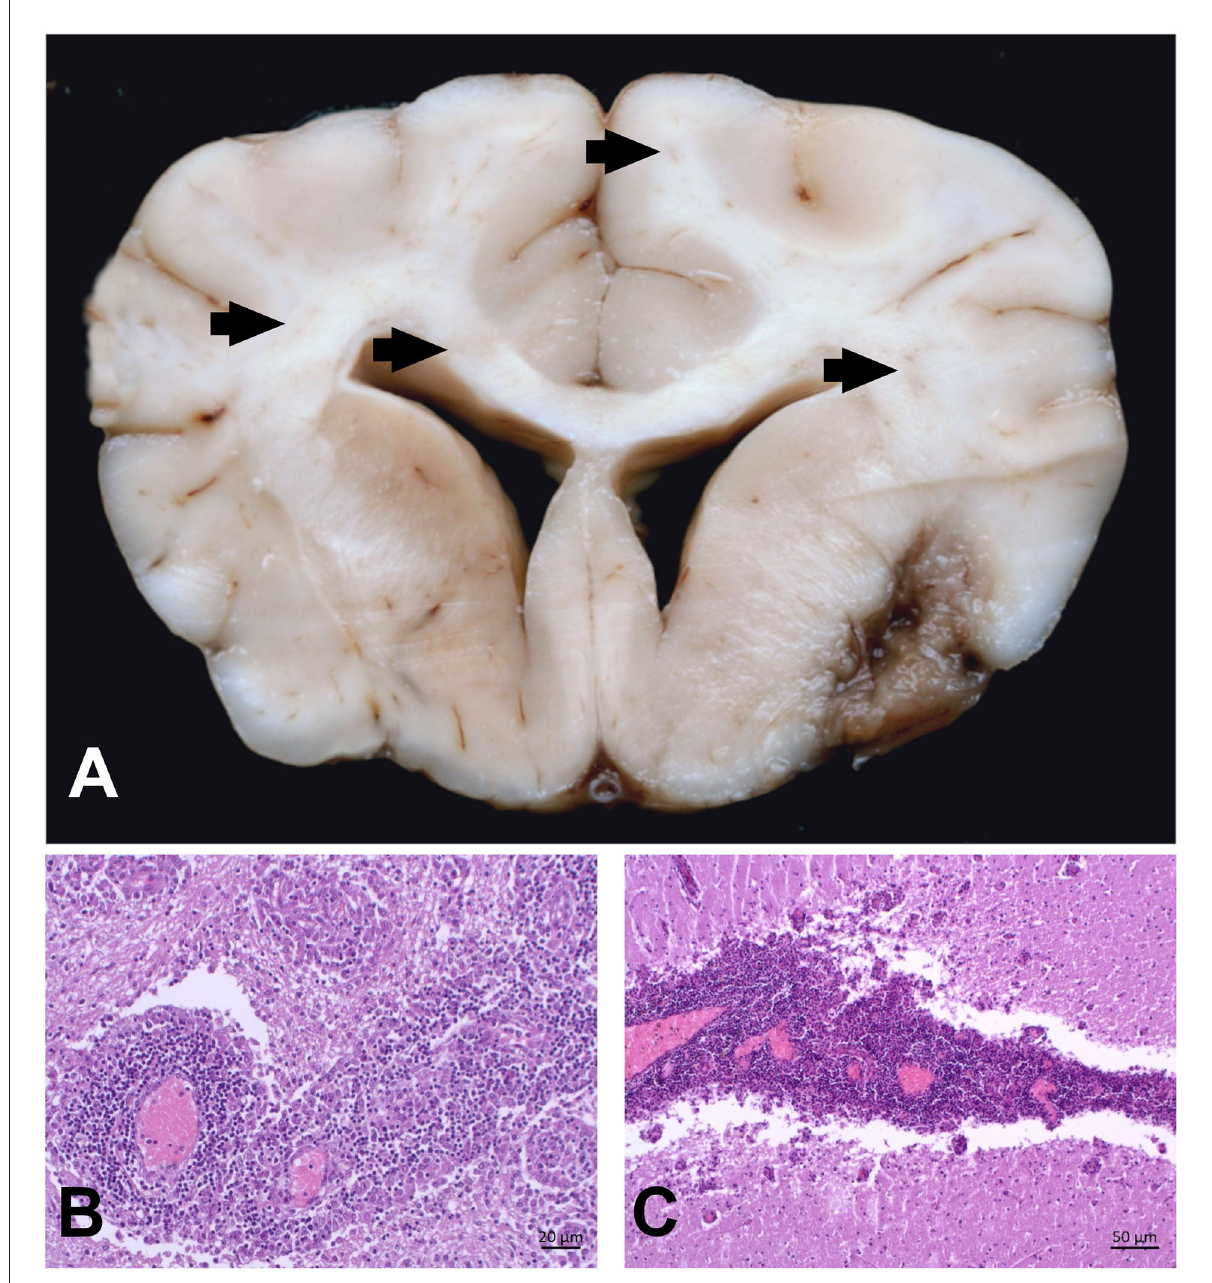
FIGURE4 Combined necrotizing and granulomatous meningoencephalitis in the brain of a Yorkshire Terrier (case 3). (A) Severe, focal-extensive and delineated malacia in the right rhinal cortex and extending to the surface. This lesion mimicks NME. Additionally, there are multifocal areas of beige discoloration in the corona radiata (arrows). (B ) Severe and multifocal-coalescing perivascular cuffs with lymphocytes and large activated macrophages. Macrophages tend to compartmentalize within these cuffs. (C) The same dog is affected by a marked cerebellar meningitis that extends into the molecular